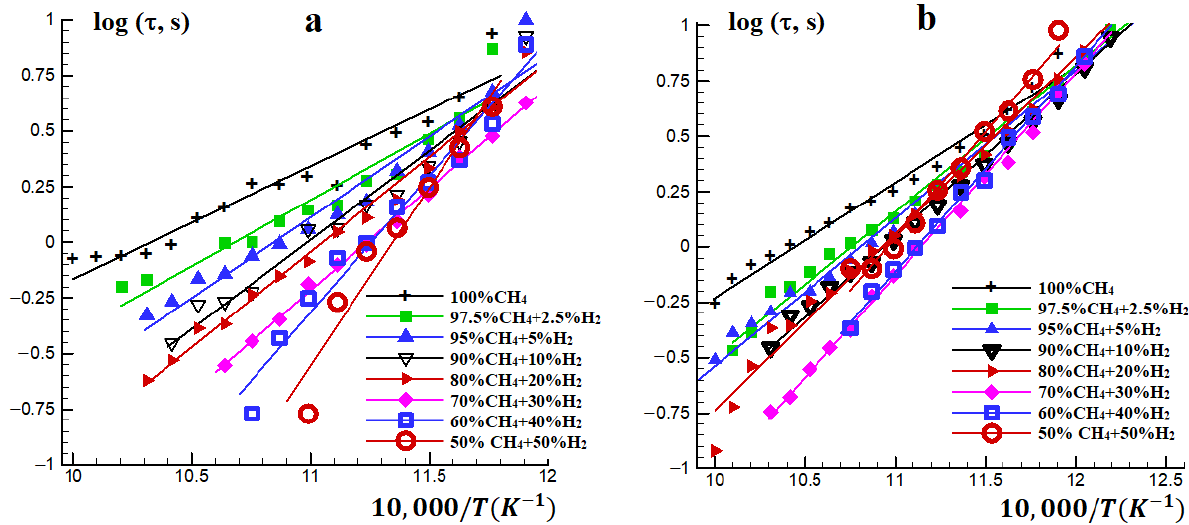
Figure 2. Temperature dependence of the autoignition delay time for stoichiometric methane – hydrogen-air mixtures at P 0 = ( a ) 1 and ( b ) 3 atm.